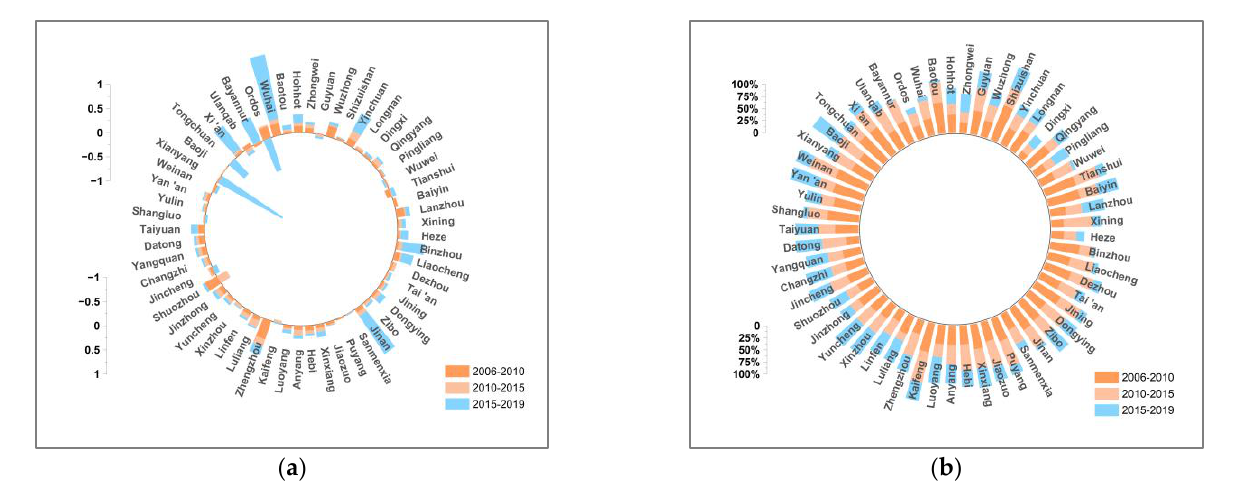
Figure 12. Contribution and contribution rate of population-scale factor. ( a ) Contribution of population-scale factor. ( b ) Contribution rate of population-scale factor.